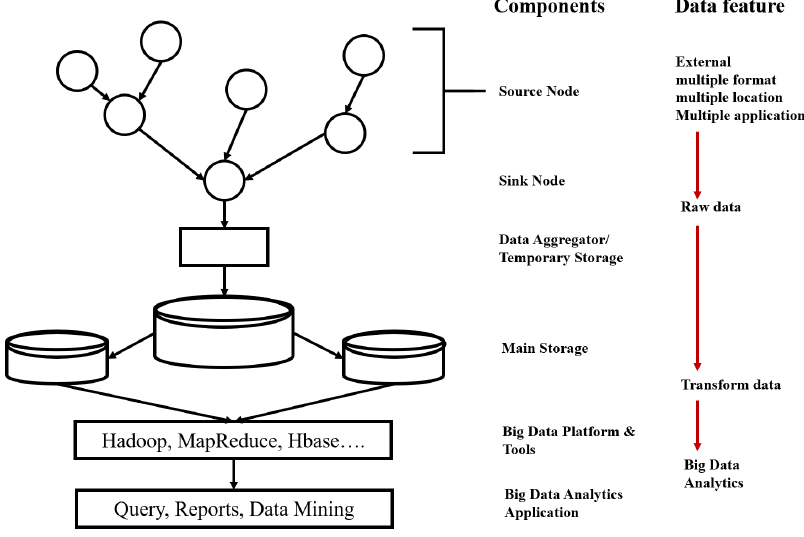
Figure 1. Big data system based on a